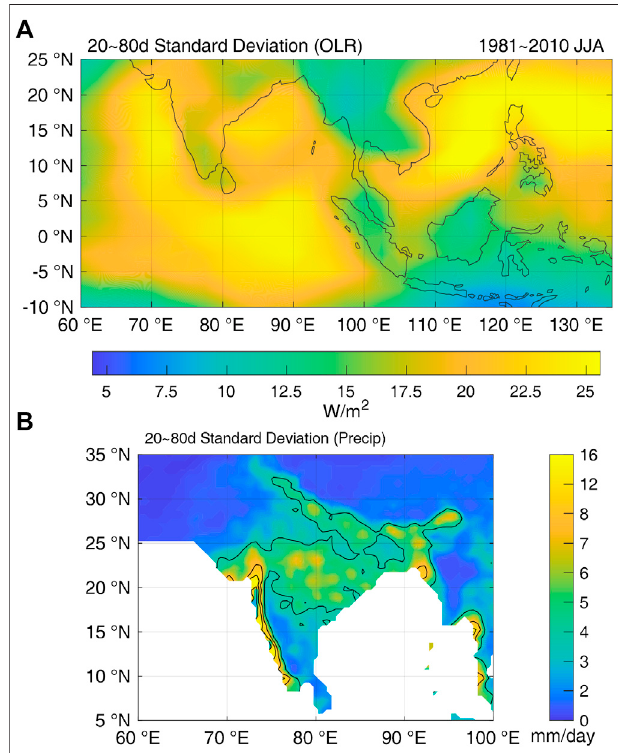
FIGURE1| Standarddeviationsof20-to80-day fi ltereddailyanomalies of (A) OLR over the Indo-western Paci fi c, and (B) rainfall over South Asia during 1981 – 2010 summer (JJA). The contours in (B) have an interval of 4 mm/day.